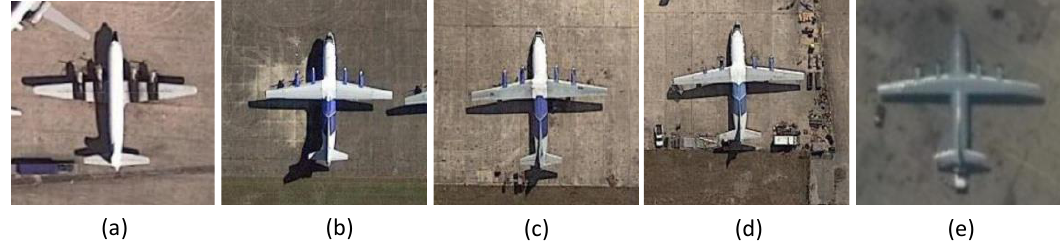
Figure 13. Examples of Type1 in the test set, where ( a ) is also different from other images in that the rear side of the wing has a certain curvature, while the rear side of the wing of other images is a straight line.